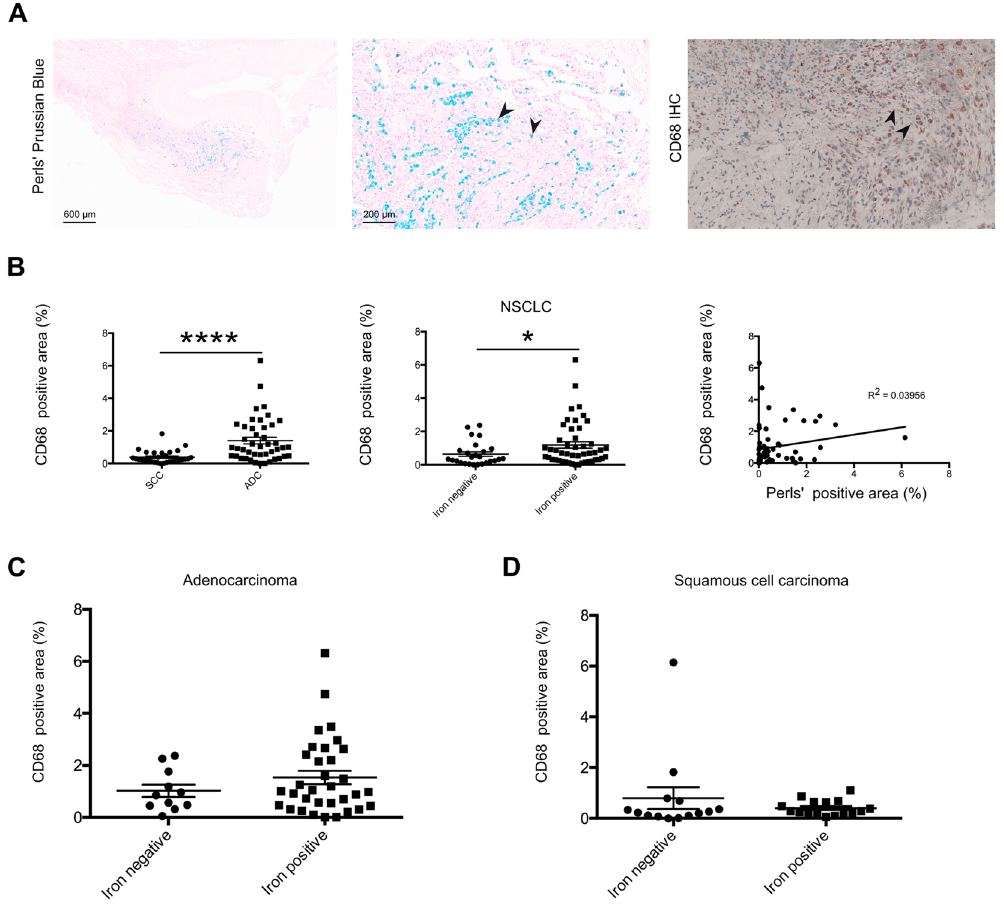
Figure 3. Higher numbers of tumor associated macrophages were detected in tumor periphery of adenocarcinoma compared to squamous cell carcinoma. ( A ) Representative examples of the staining methodologies applied showing spatial connection between CD68 positive macrophages and iron positive cells (provided example shows lung adenocarcinoma). Blue staining indicates iron and red staining indicates CD68 positive cells. Arrowheads indicated in the middle and the left show staining of positive cells. ( B , left) Quantification of CD68 immunohistochemistry staining in lung tumor tissue samples of adenocarcinoma (n = 44) and squamous cell carcinoma (n = 30). ( B , center) Comparison of the macrophage content of iron positive (n = 48) and iron negative (n = 26) tissue samples of NSCLC patients. ( B , right) Linear regression of iron content and CD68 positive macrophage content. ( C ) Quantification of CD68 immunohistochemistry staining in lung tumor tissue samples of adenocarcinoma and comparison between the iron positive (n = 33) and iron negative (n = 11) samples. ( D ) Quantification of CD68 immunohistochemistry staining in lung tumor tissue samples of squamous cell carcinoma and comparison between the iron positive (n = 16) and iron negative (n = 14) samples. CD68 positive area represents the relative amount (in percent) of positive staining. Statistical tests performed are Mann-Whitney U test and linear regression. Data is shown as mean ± SEM. * p < 0.05, ** p < 0.01, *** p < 0.001, **** p <